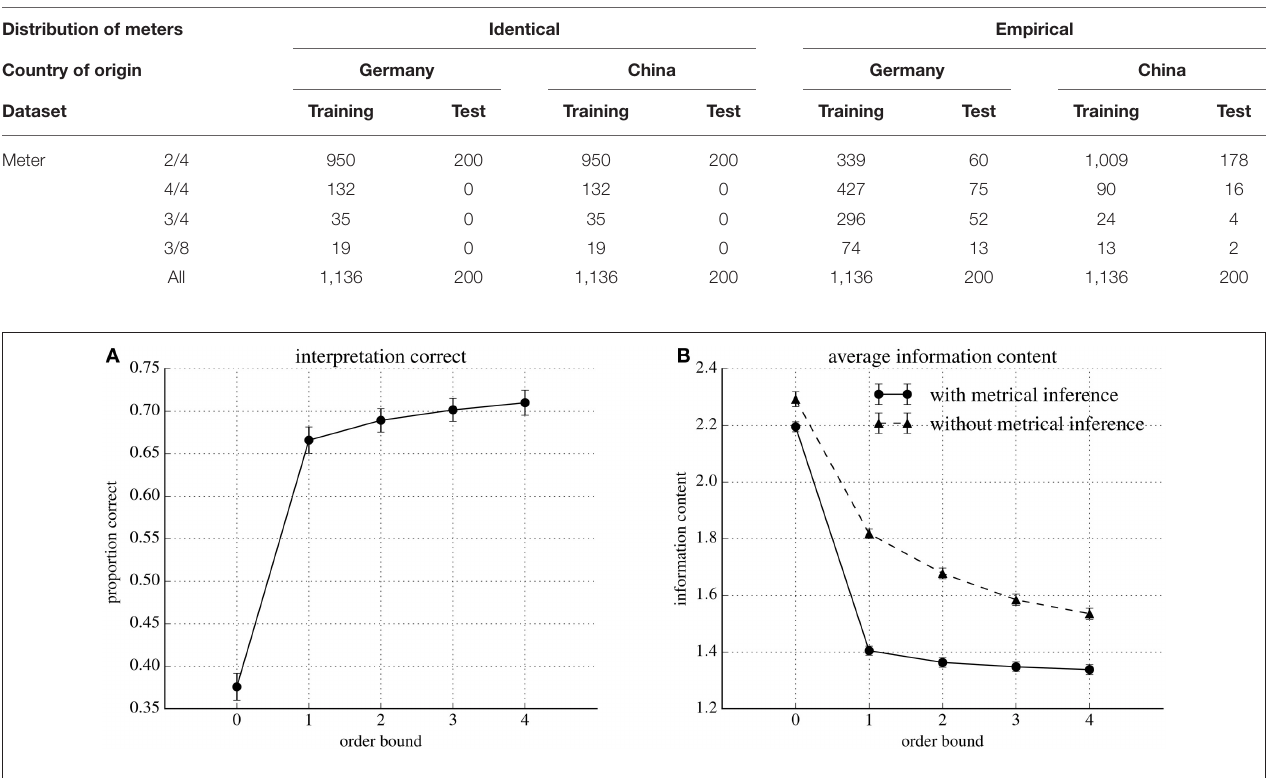
FIGURE 3 | Classification performance and average information content for five different models varying in order-bound, evaluated using ten-fold cross-validation. Markers represent values obtained by averaging over the ten folds. Error bars extend one standard deviation above and below the average values. (A) Proportions of correctly classified interpretations. (B) Average information contents for the model (with metrical inference) compared to IDyOM without metrical inference.